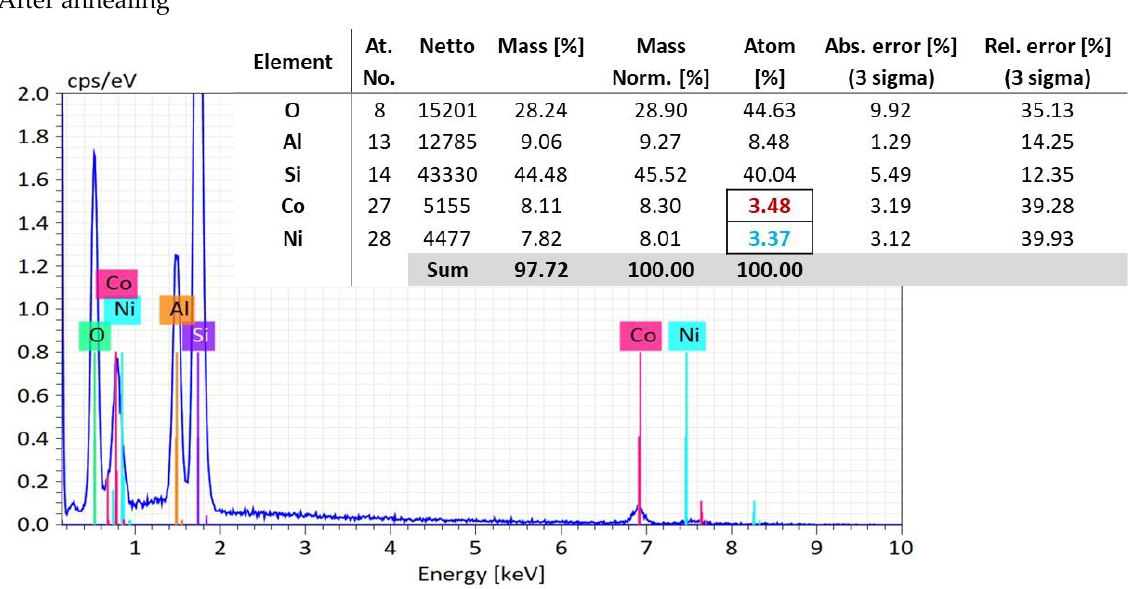
Figure 4. EDX analysis measured at three points, and compositional analysis.